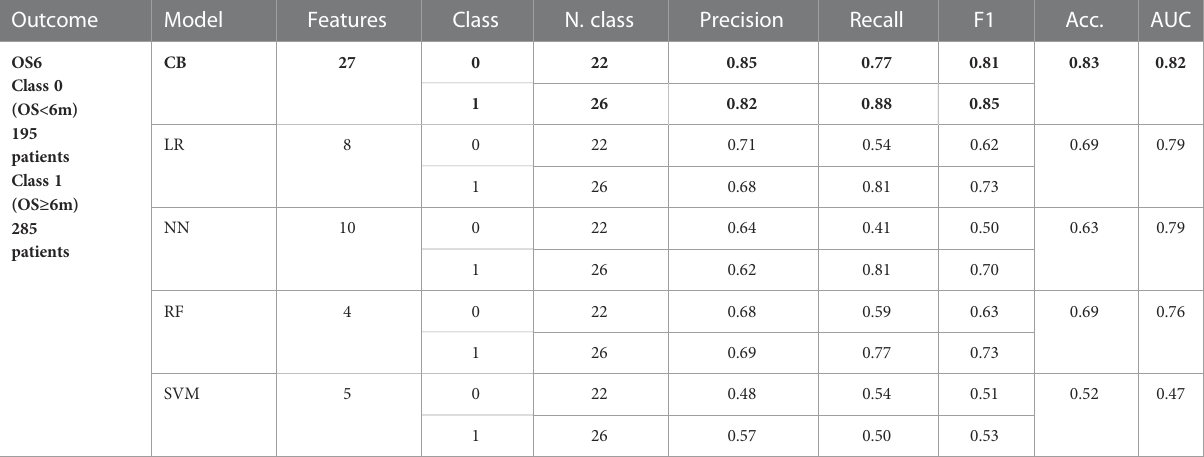
TABLE 4 Performance of classi fi cation models on the test dataset; outcome – OS6.